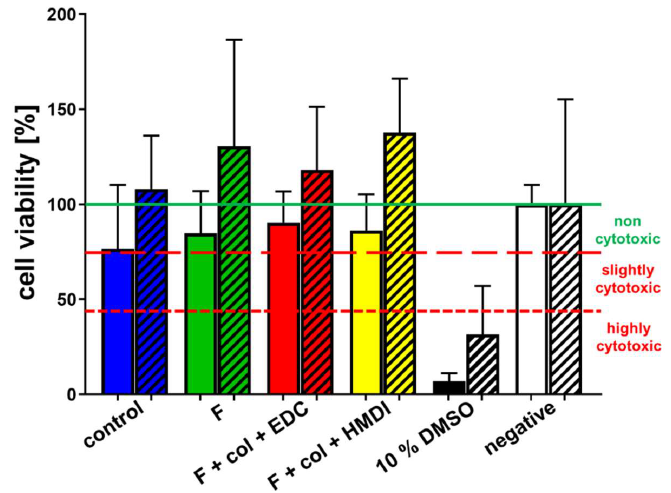
Figure 2. Cytotoxicity Assay of four different scaffold functionalization variants. Viability of L929 (full) and LACL-derived (shaded) fibroblasts treated for 24 h with scaffold extracts (48 h extraction) prepared from the control scaffolds without functionalization (blue), the only fluorinated scaffolds (green) or variants fluorinated + collagen foam + EDC cross-linking (red) or fluorinated + collagen